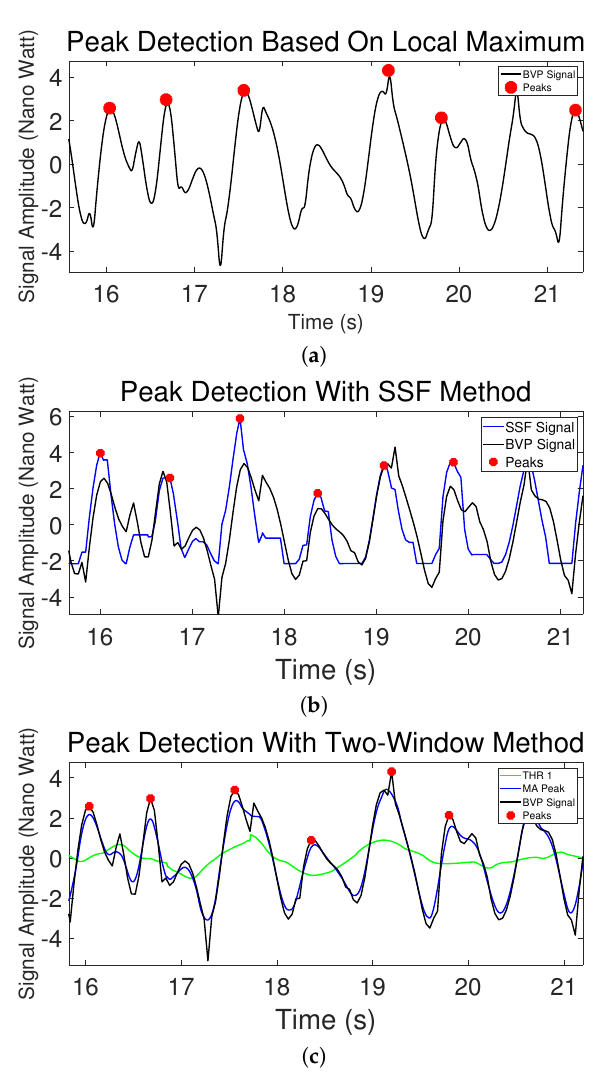
Figure 5. Peak detection on rPPG signal (BVP) with ( a ) Local Maximum, ( b ) SSF and ( c ) Two-Window